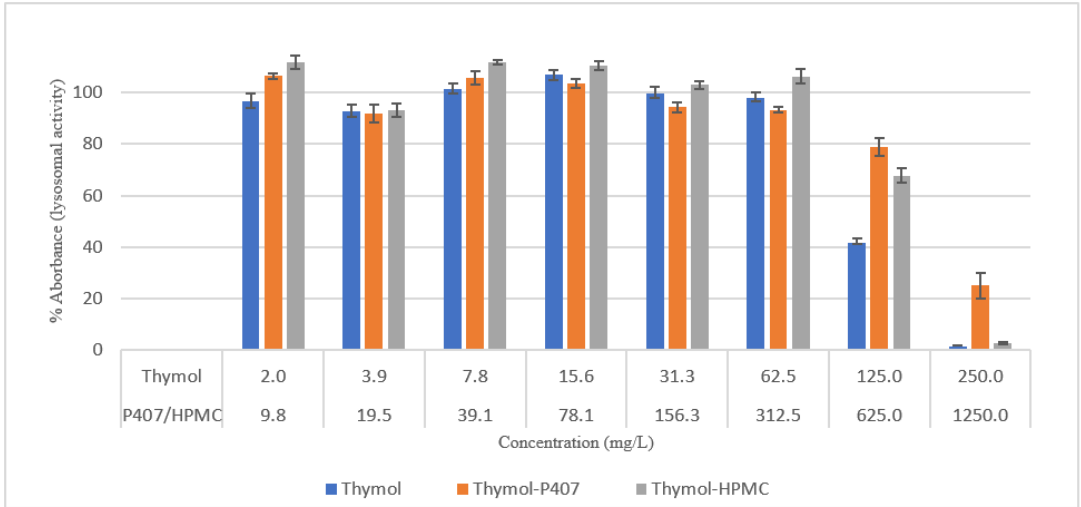
Figure 6. Effect of thymol on the lysosomal activity of HEK293 cells, 2-h exposure, measured using neutral red uptake assay. Each point represents the mean percentage ± SE, n = 6.